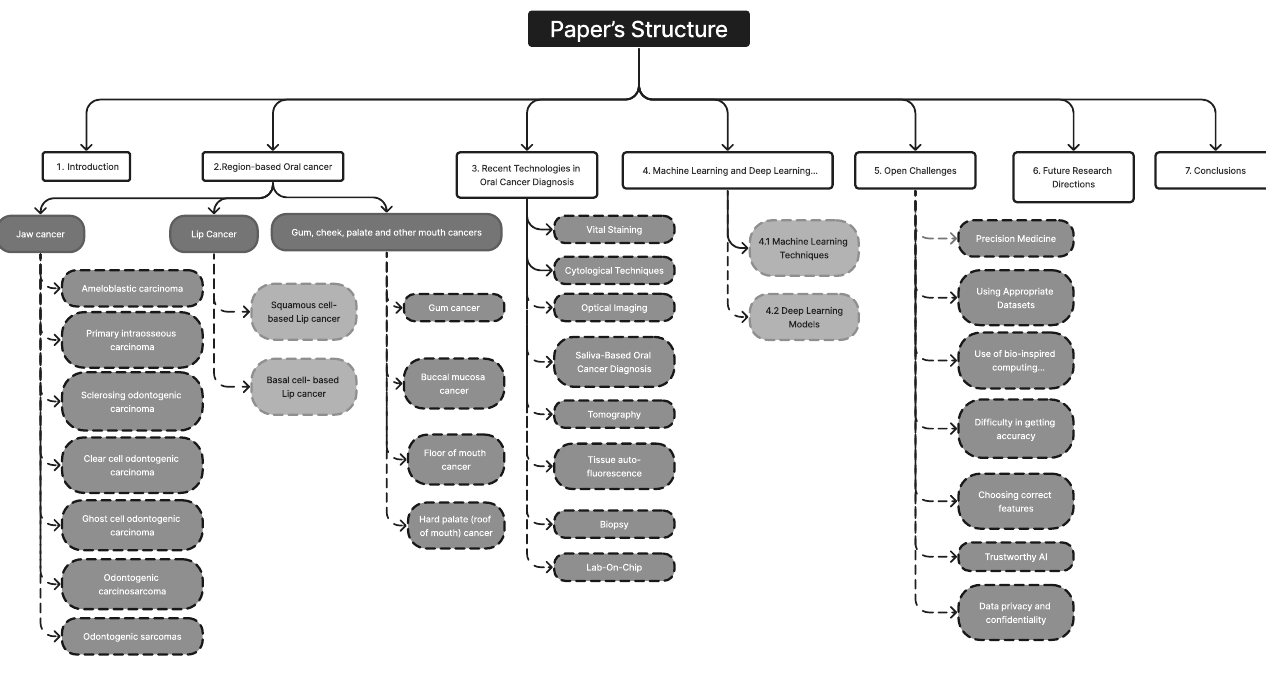
Figure 6. Structure of this article.